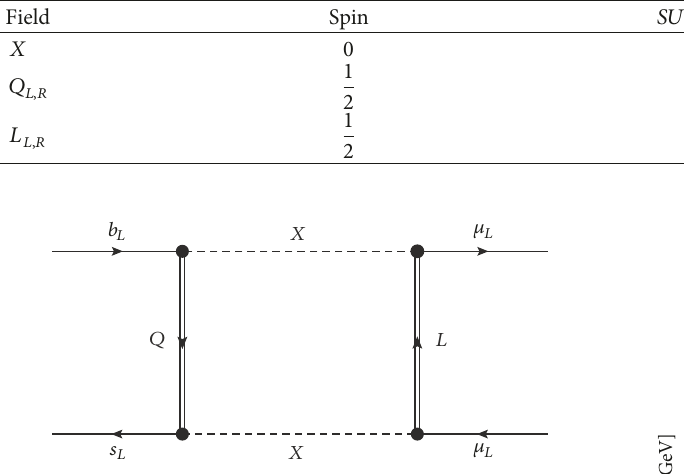
Figure 4: Generation of O 9 and O 10 in the model of [13]. Semi- Leptonic four-fermion operators are generated at the 1-loop level.